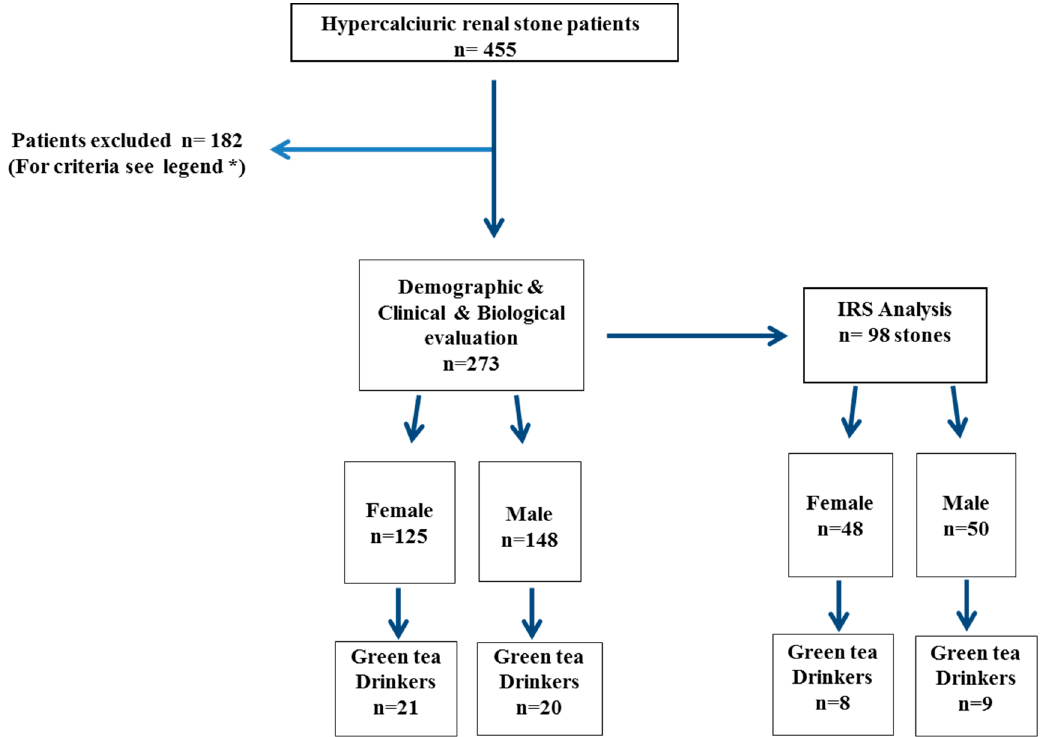
Figure 1. Flow chart. Primary hyperparathyroidism or sarcoidosis ( n = 28); bowel resection ( n = 2), steroid, bisphosphonate, and antiretroviral treatment ( n = 23); vegetarian diet or “exotic” infusions ( n = 25); food supplements ( n = 22); intermittent green tea intake ( n = 6); daily black tea intake ( n = 36); diuretics, vitamin D treatment ( n = 39); pregnancy ( n = 1). IRS: infrared analysis.